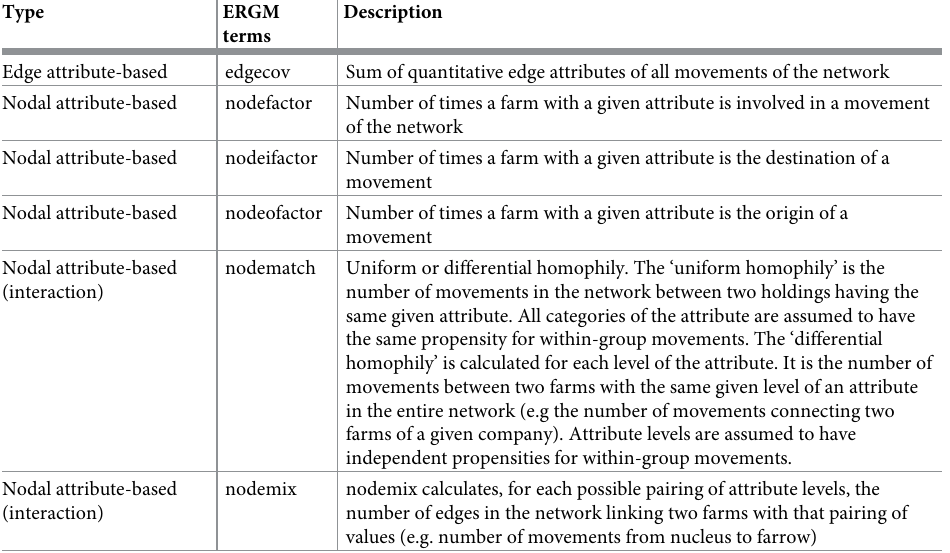
Table 6. Description of exponential random graph model terms used in the stepwise approach.